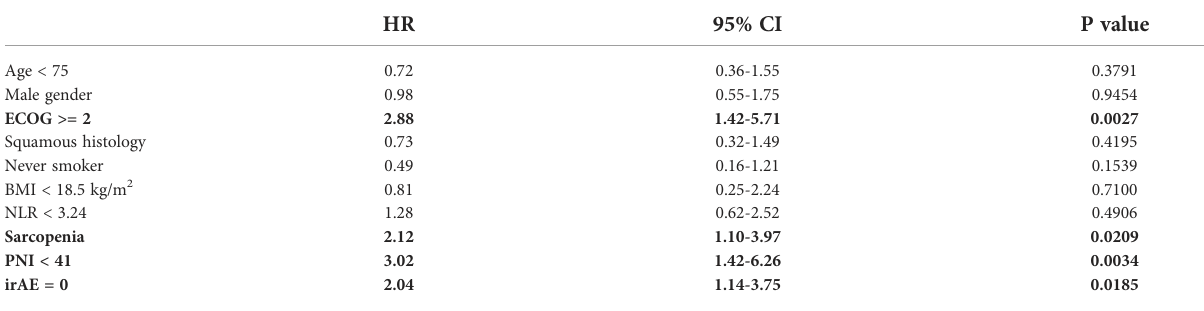
TABLE 2 Cox proportional hazards regression model assessing the effect of patient-speci fi c variables on overall survival. Cox proportional hazards regression (Wald test, P <0.0001) HR 95% CI P